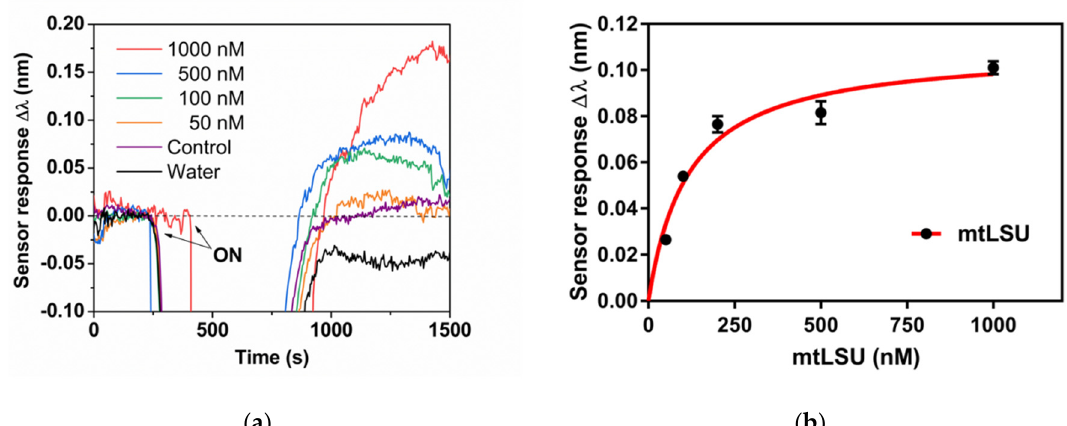
Figure 5. mtLSU rRNA detection. ( a ) Real-time monitoring of wavelength displacements ( Δ λ vs time) corresponding to the hybridization of different mtLSU rRNA concentrations (1000, 500, 100 and 50 nM, respectively) diluted in water, control DNA and water in a PPRH: CH 3 –PEG–SH (1:1) monolayer. ( b ) Calibration curves of mtLSU rRNA on water using SSC 2.5 X + 5% FA as running buffer. Sensor response represents the mean ± SD of three measurements.